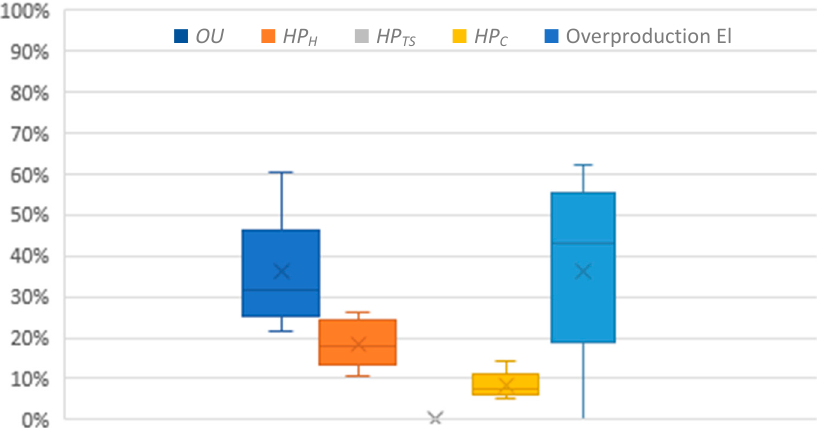
Figure 15. Box and whisker plot of the percentage of the electrical uses with respect to the total electricity production.